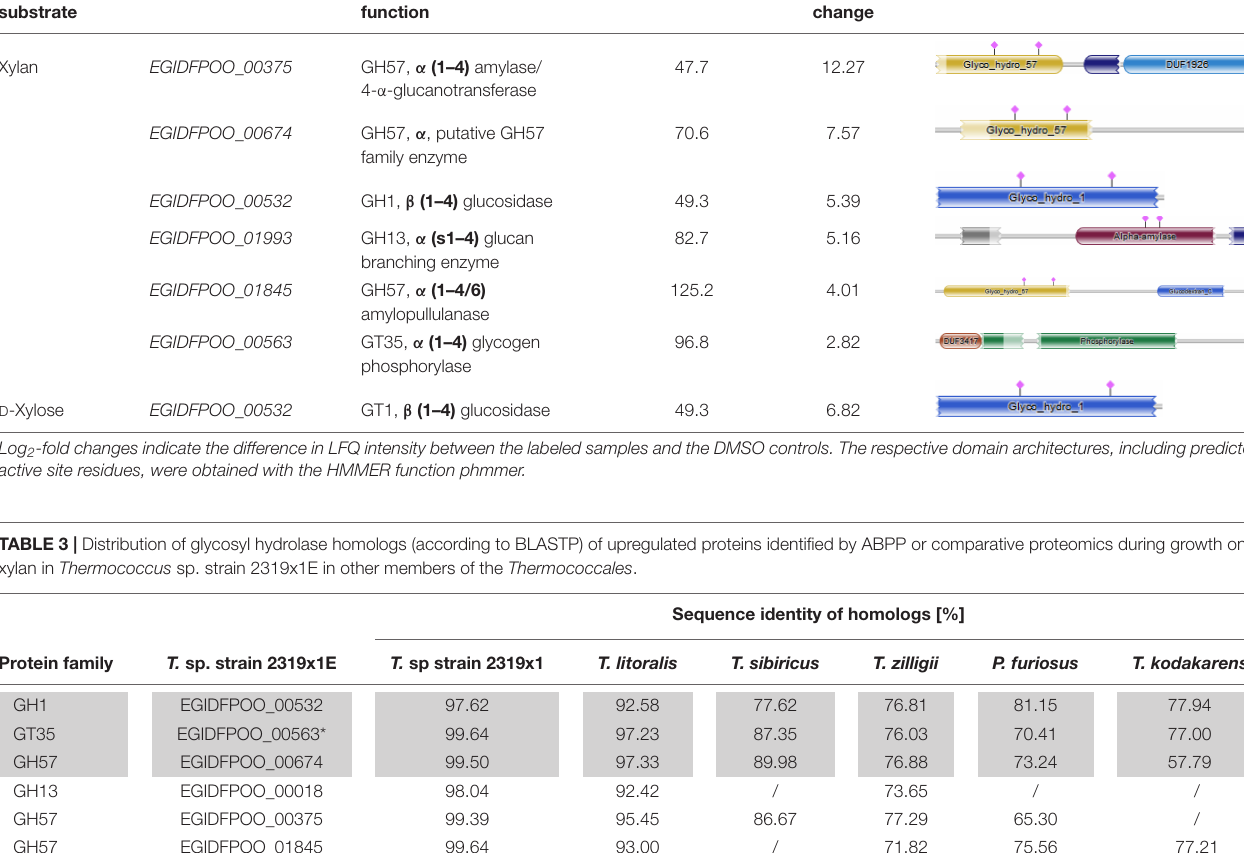
TABLE 2 | Overview of CAZymes enriched from Thermococcus sp. strain 2319x1E cultures grown on xylan or D -xylose using the α -selective probe JJB384. Growth Gene Protein family and predicted substrate function